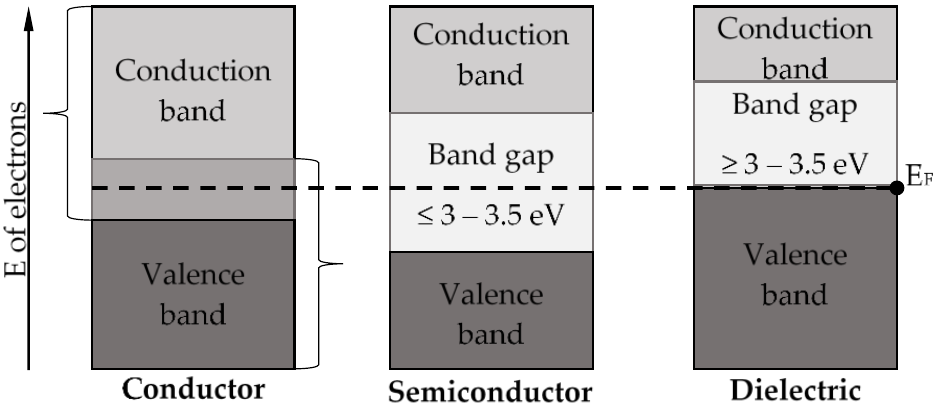
Figure 15. Classification of materials by conductivity (according to zone theory).